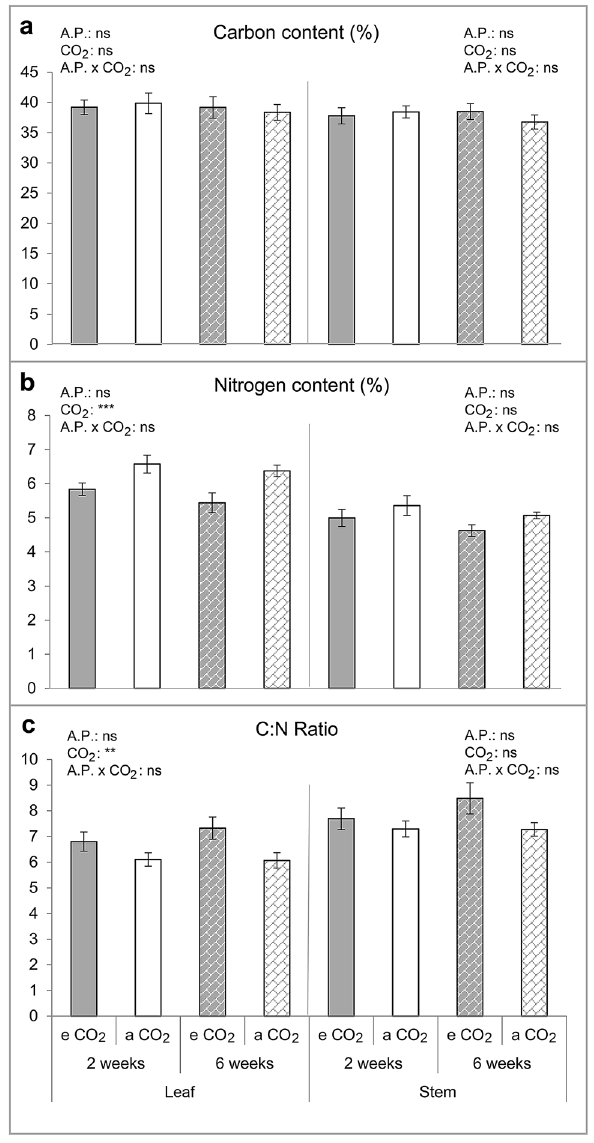
Figure 1. Melon carbon and nitrogen concentration profile. ( a ) Carbon (C) concentration (%), ( b ) Nitrogen (N) concentration (%) and, ( c ) C:N ratio from leaves and stems of melon plants measured after a previous acclimation period (A.P.) to two or six weeks to elevated CO 2 (eCO 2 ) (700 ppm) or ambient CO 2 (aCO 2 ) (400 ppm). Mean values ± SE are shown (n = 9). **(P ≤ 0.01) and ***(P ≤ 0.001) when statistically significant differences were found, ns (no statistically significant differences) (Two-way ANOVA and LSD tests). Melon leaf C:N ratio data were transformed by log (x +